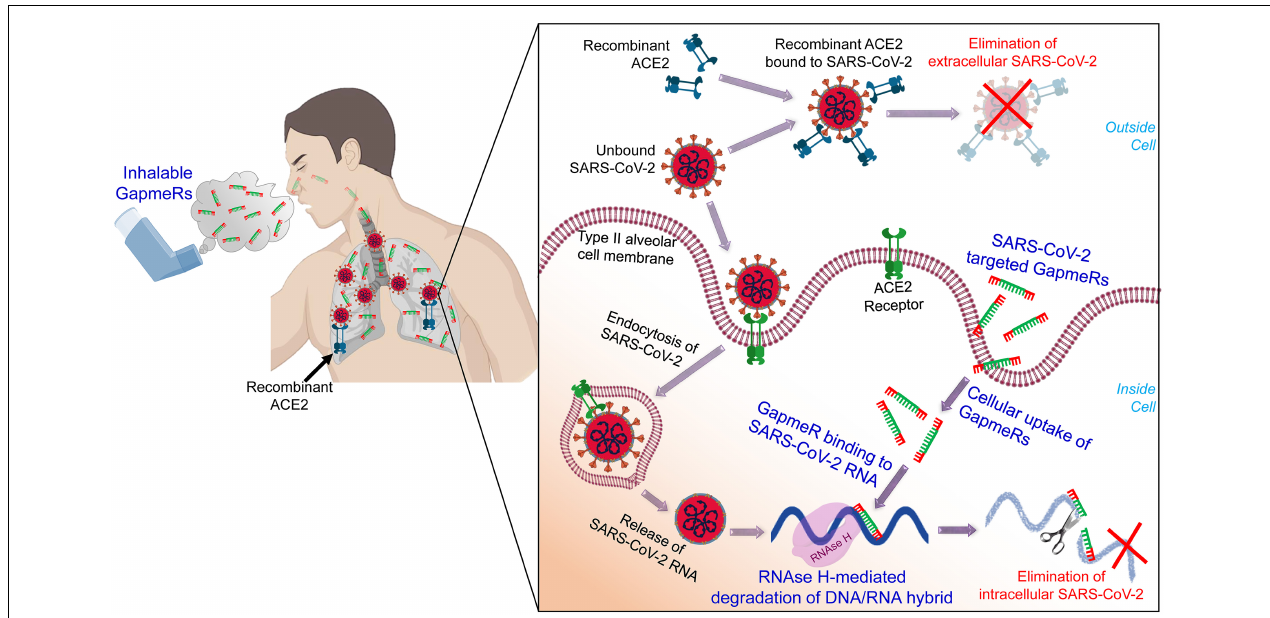
FIGURE 1 | A schematic illustration of administering inhalable GapmeRs and recombinant ACE2 to the lung for treating COVID-19. The proposed mechanism of action of SARS-CoV-2 targeted GapmeR molecules in destroying intracellular viral RNA in type II alveolar cells and recombinant ACE2 in eliminating extracellular virus particles in the lung. Figure prepared using images created with